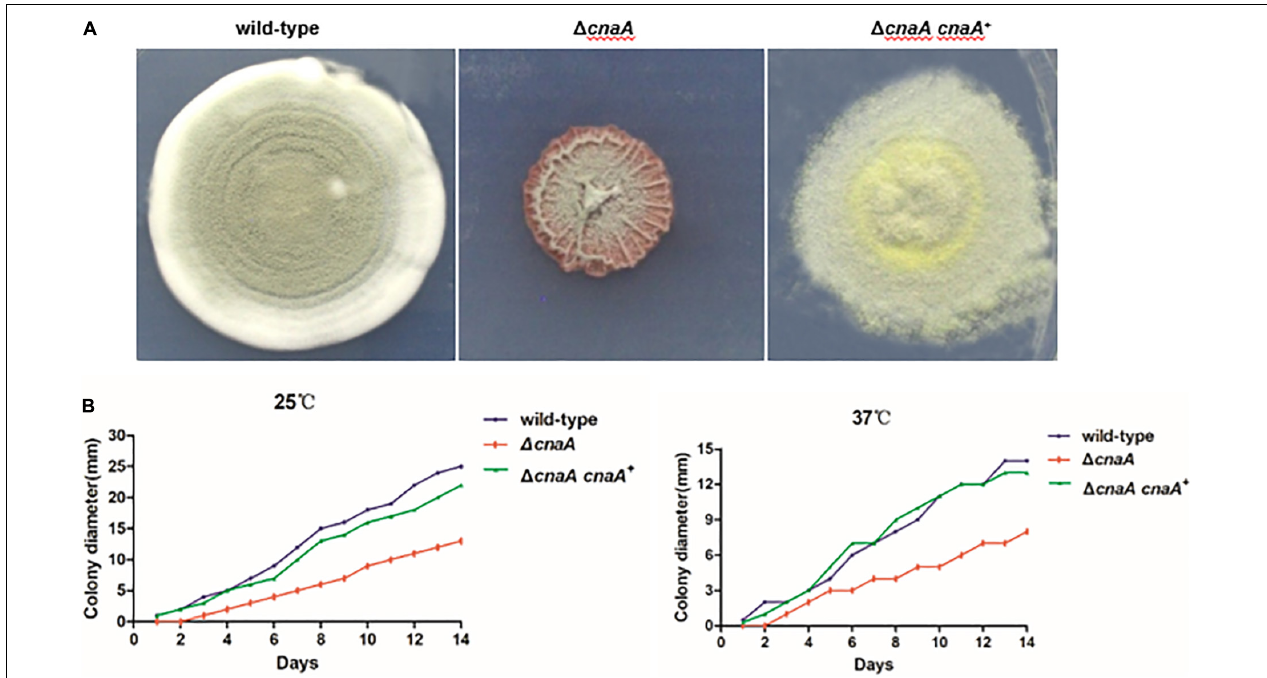
FIGURE 1 | Loss of cnaA affects colonial morphology and radial growth. (A) T. marneffei wild-type and (cid:49) cnaA cnaA + strains exhibited highly vegetative hyphae that appeared fluffy and green and developed many conidiophores at 25 ◦ C when grown on ANM. The colony edge was relatively uniform and compact. Colonies of the (cid:49) cnaA mutant showed thin growth and exhibited decreased aerial hyphae production, resulting in a film-like surface morphology that was wrinkled. (B) Conidia from each strain were inoculated on ANM or BHI medium and incubated for 1–14 days at 25 ◦ C and 37 ◦ C. The (cid:49) cnaA mutant grew less than the wild-type and (cid:49) cnaA cnaA + complemented